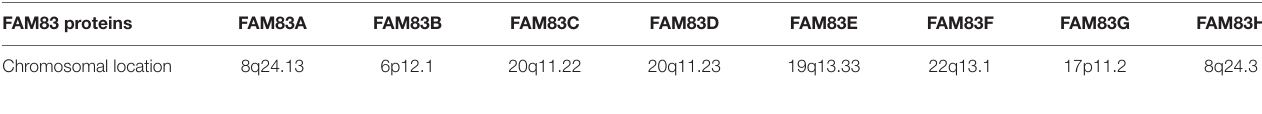
TABLE 1 | The distinct chromosomal locations of FAM83A–H members. FAM83